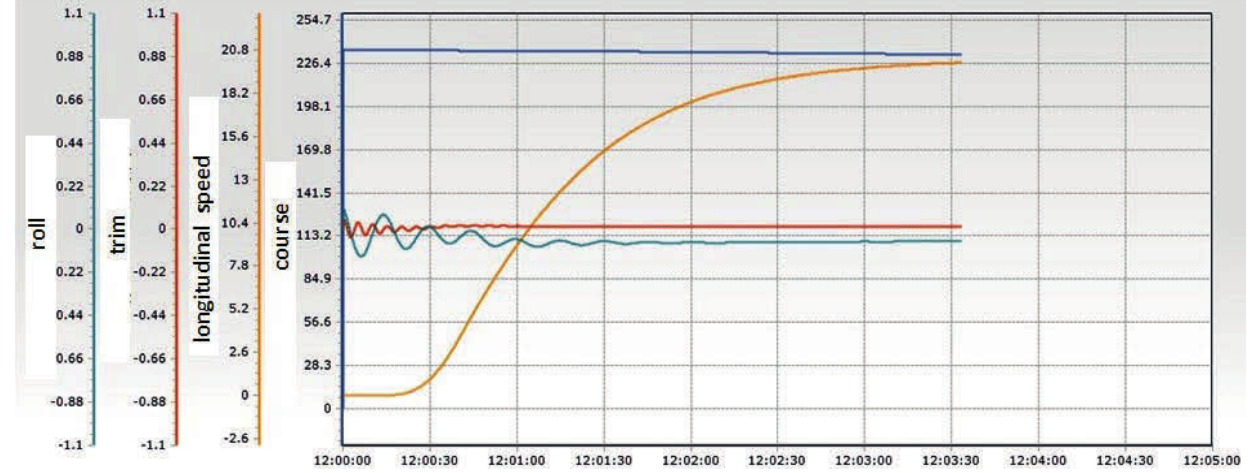
Fig. 4. Parameters of the Ro-Ro passenger ferry 13 movement with course K = 0 at full calm.